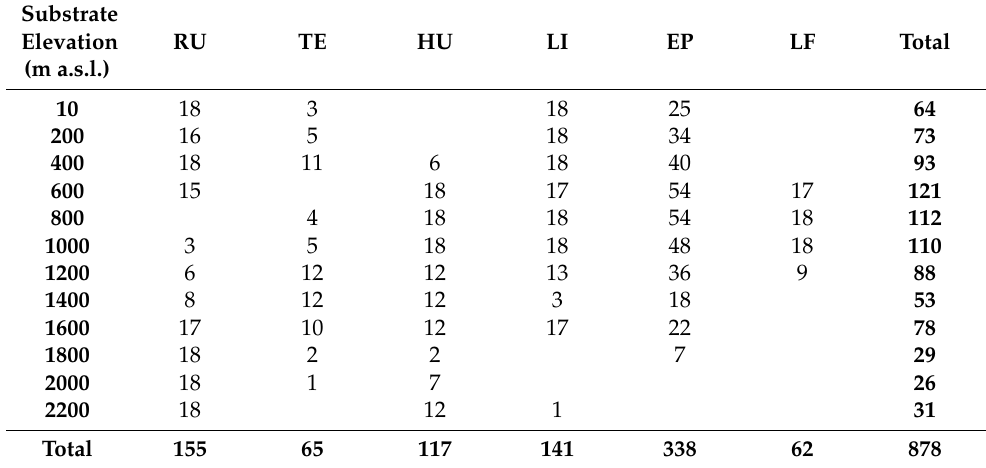
Table 1. Distribution of the collected microplots per substrate (RU = rupicolous; TE = terricolous; HU = humicolous; LI = lignicolous; EP = epiphytic; LF = epiphyllous) for the 12 study sites along the elevational transect of Pico Island. Substrate Elevation (m a.s.l.)